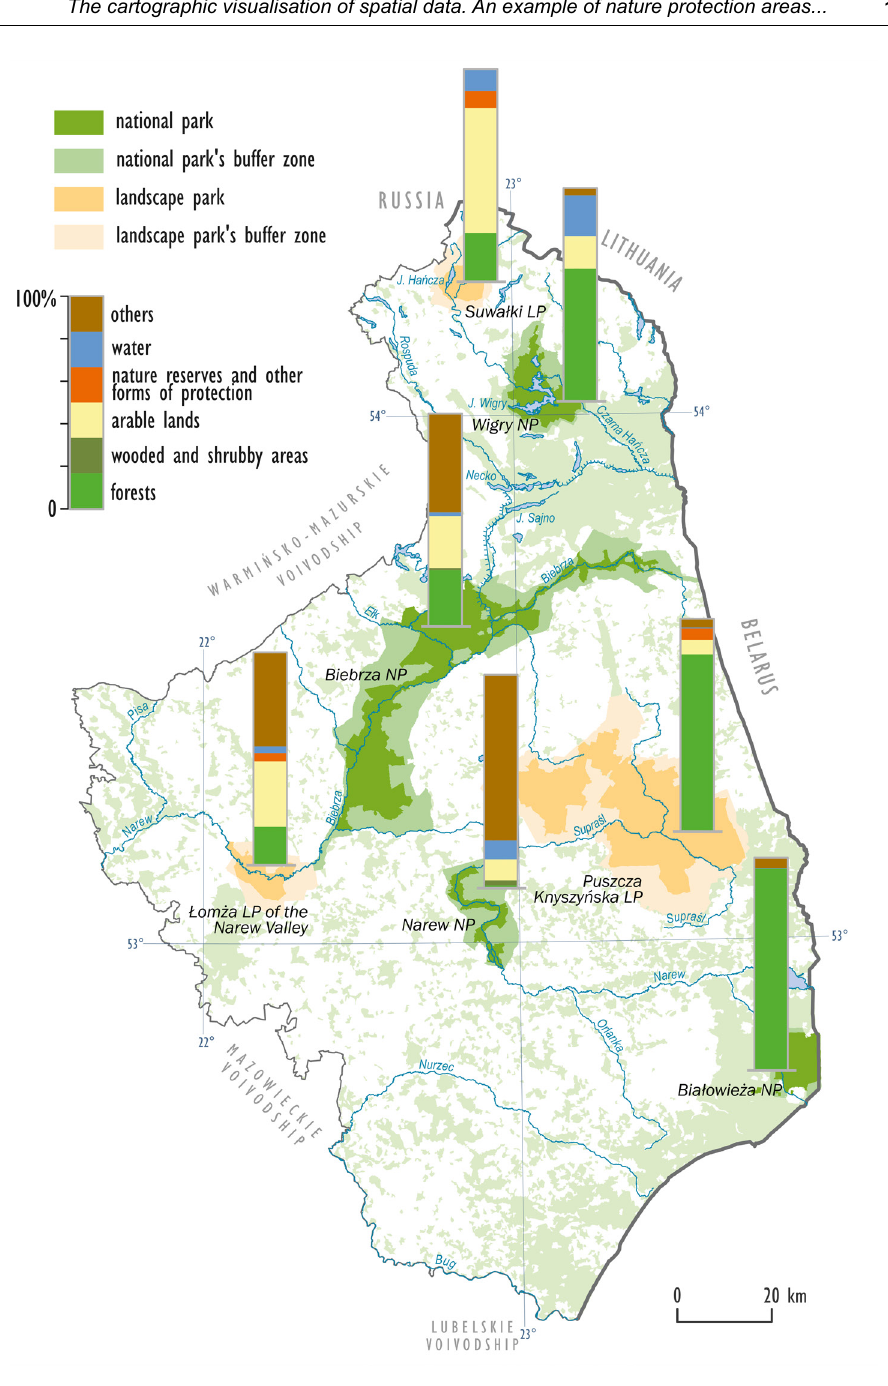
Fig. 5. National parks and landscape parks land